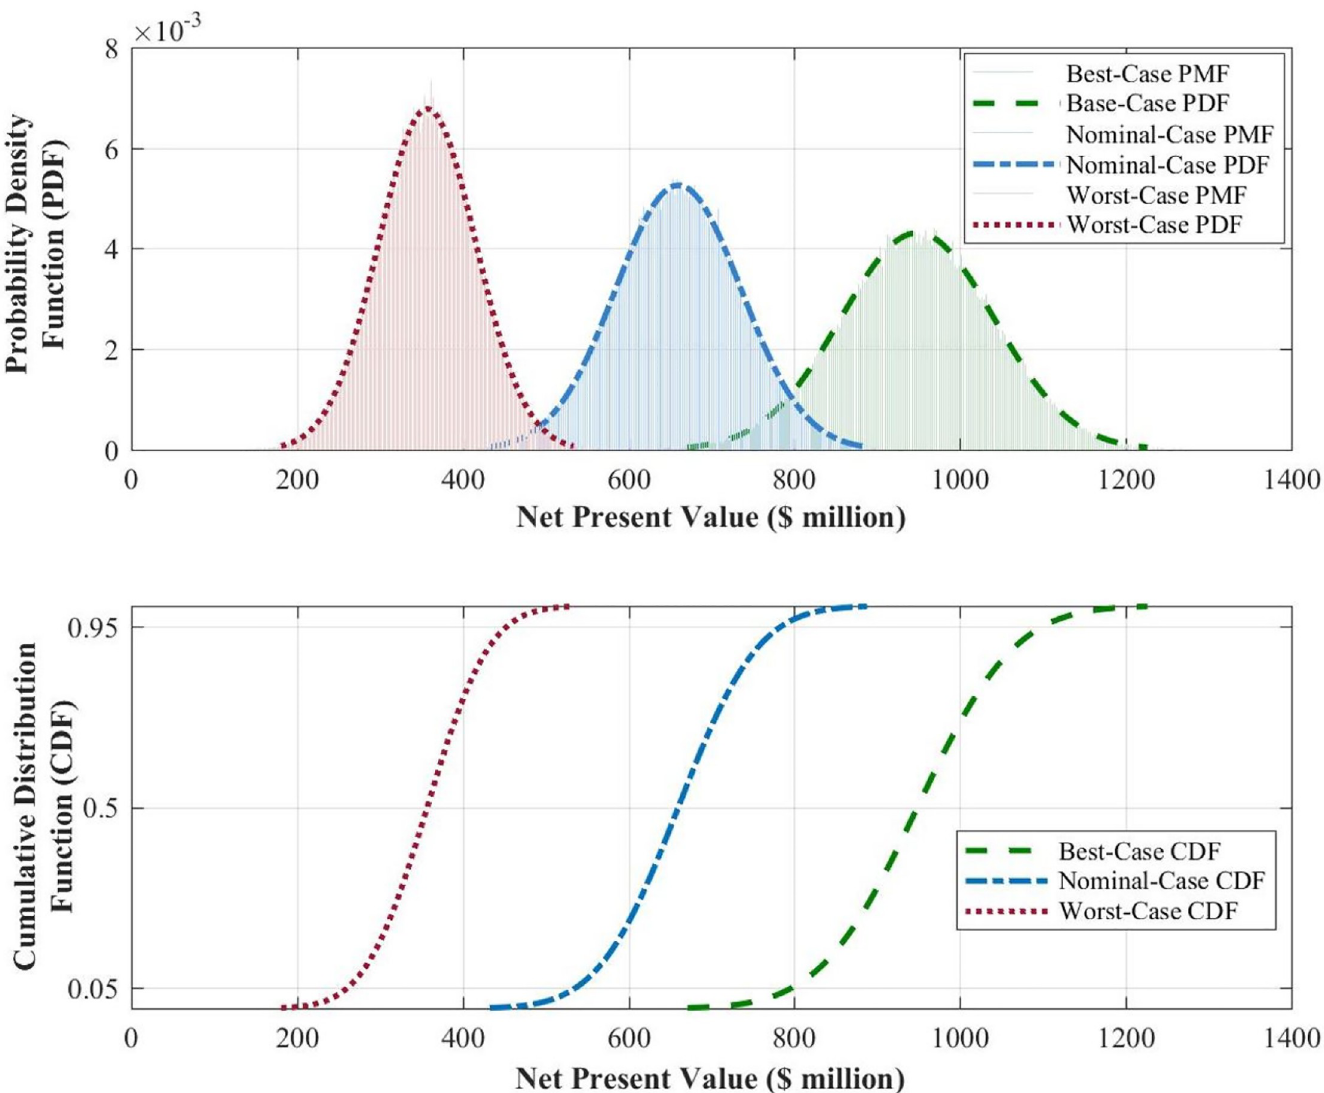
Fig 9. NPV analysis of HTS under three scenarios best-, nominal-, and worst-case loading conditions for a medium-sized HTS with a throughput capacity of 100 Gbps, ARPU of $40/month, and a downlink speed of 12 Mbps over a design life of 15 years on-orbit (details in Table B in S1 Appendix).